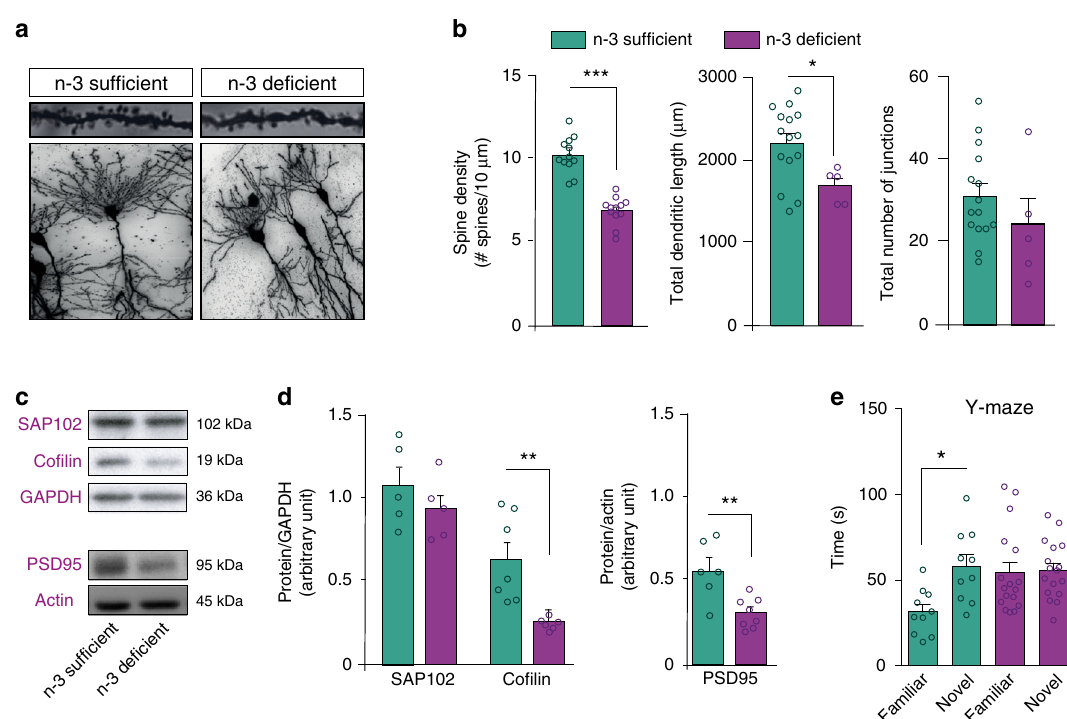
Fig. 1 Maternal n-3 PUFA de fi ciency alters neuronal morphology and function. a Representative images of tertiary apical dendrites (upper panel) and dendritic arborization (lower panel) of hippocampal CA1 pyramidal neurons from n-3 suf fi cient and n-3 de fi cient mice at P21 (Golgi staining). b Quanti fi cation of spine density, total dendritic length and total number of junctions in n-3 de fi cient and n-3 suf fi cient animals. For spine counting, n = 12 CA1 pyramidal neurons of the hippocampus, 15 – 45 segments per animal, 3 mice per group. Means ± SEM. Two-tailed unpaired Student ’ s t -test, t = 6.396, *** p < 0.0001. For dendritic arborization and total dendritic length, n = 5 neurons from 3 mice for n-3 de fi cient mice and n = 15 neurons from 4 mice for n-3 suf fi cient mice. Two-tailed unpaired Student ’ s t -test; Dendritic length, t = 2.501, * p = 0.0223; number of junctions: t = 1.118, p = 0.28. c Representative western blots. d Expression of scaffolding proteins in n-3 de fi cient mice relative to n-3 suf fi cient mice. Means ± SEM; n = 5 – 8 mice per group. Two-tailed unpaired Student ’ s t -test, t = 0.9986, p = 0.35, SAP102; t = 3.572, ** p = 0.0044, co fi lin; t = 3.529, ** p = 0.0042, PSD95. e Time sp e nt in novel vs familiar arm in the Y maze task. Means ± SEM; n = 10 – 17 mice per group. Two-way ANOVA followed by Bonferroni post hoc test: diet effect, F (1,50) = 5.47, p = 0.071; arm effect, F (1,50) = 10.08, p = 0.015; interaction, F (1,50) = 8.08, p = 0.029; familiar vs novel arm for n-3 diet mice: * p < 0.05. Source data are provided as a Source data fi